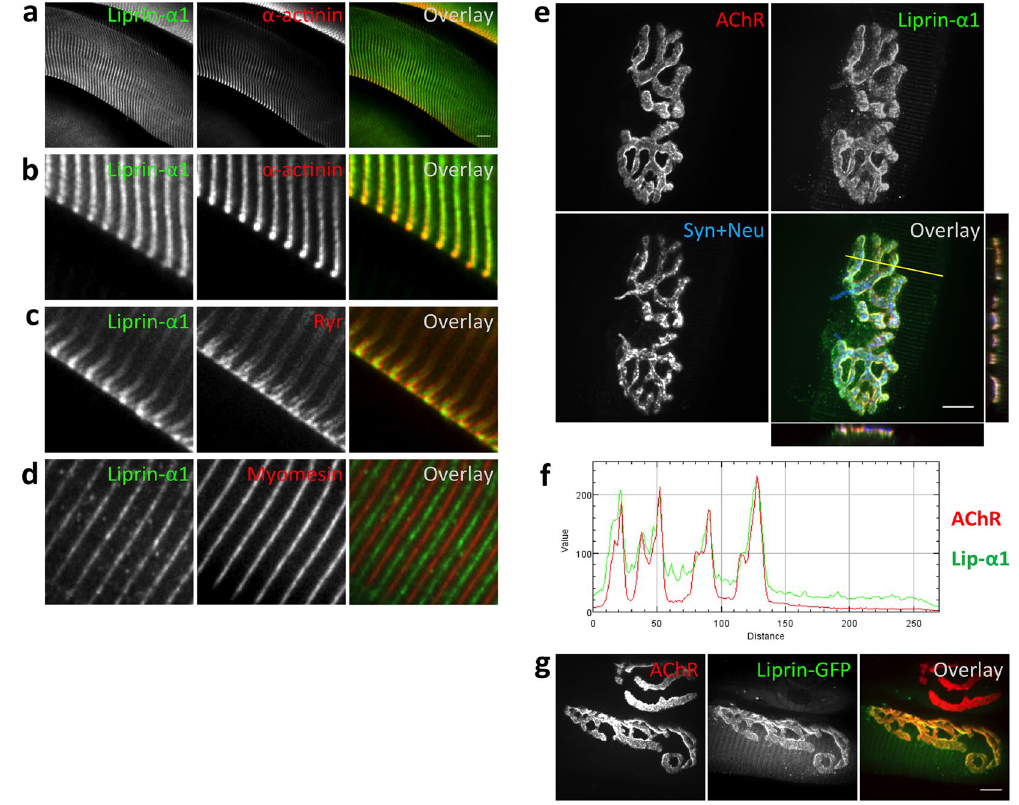
Figure 1. Liprin- α -1 localizes to Z-discs and NMJs in skeletal muscles. ( a – d ) Liprin- α -1 localized to the Z-discs of contractile machinery. Tibialis anterior muscle fibers from P30 mice were stained with antibody against liprin- α -1 protein (green) and indicated markers for contractile machinery (red). ( b ) Shows a higher magnification of an area in ( a ). ( e ) Liprin- α -1 (green) was enriched mainly at the postsynaptic machinery of the NMJ. Fluorescently labeled BTX was used to visualize AChR (red), and anti-synaptophysin and anti- neurofilament were used to visualize nerve terminals (blue). ( f ) Enrichment of liprin- α -1 at the postsynaptic machinery. Fluorescence intensity for liprin- α -1 immunochemistry (green) and AChR (BTX, red) along the line shown in ( e ) was plotted using RGB profiler plugin to the ImageJ/Fiji software. ( g ) Liprin- α -1-GFP fusion protein localized to the NMJ on transfected fiber. AChR (red); liprin- α -1-GFP (green). Scale bar 10 μ